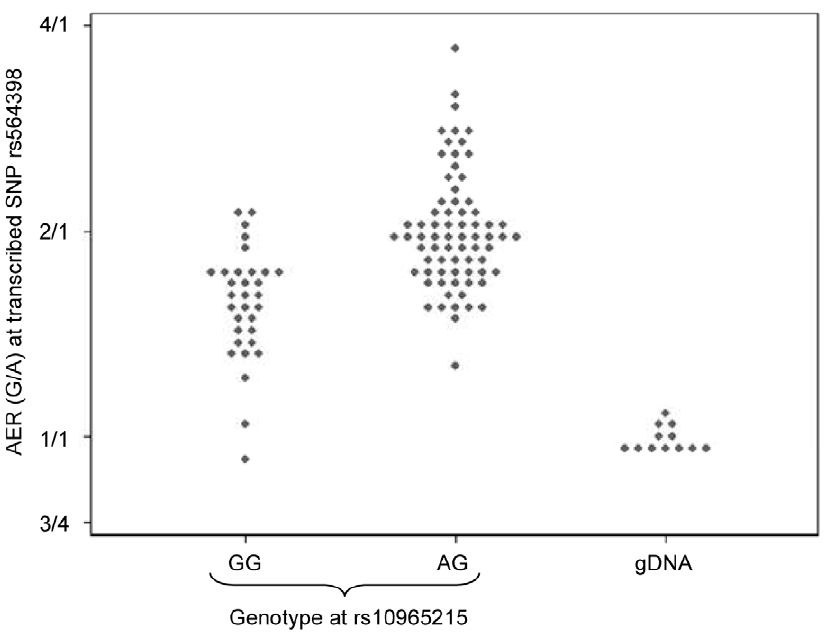
Figure 6. Effect of genotype at rs10965215 on allelic expression ratio of transcribed ANRIL SNP rs564398. Diamonds represent the allelic expression ratio for each individual, all of whom are heterozygous for the transcribed SNP rs564398. The first column shows individuals who are homozygous for rs10965215 (mean ratio 1.57), and the second column shows individuals who are heterozygous for rs10965215 (mean ratio 2.00). The third column shows the expression ratio obtained from genomic DNA in individuals who are heterozygous for the transcribed SNP rs564398, where the two alleles are present in a 1:1 ratio (mean ratio 1.00).